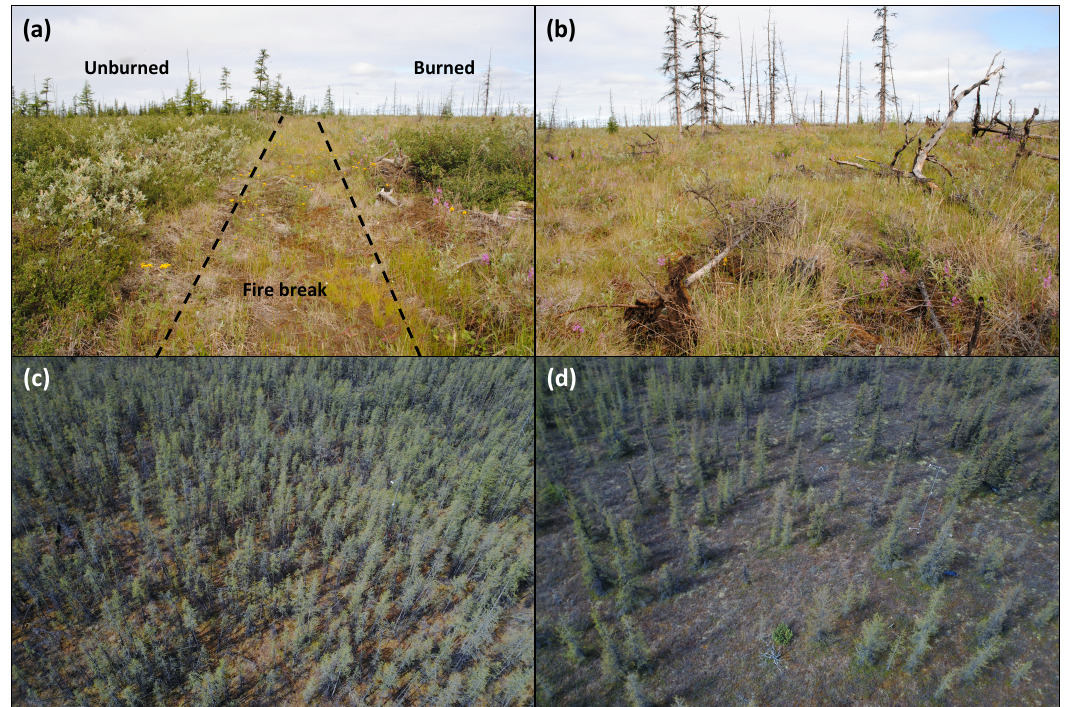
Figure 3. Impacts of fire on ecosystem structure in Siberian larch forests. A firebreak near the town of Cherskii (a) shows the contrast between burned and unburned areas ∼ 10 years post-fire, where apparent larch and shrub recruitment failure has resulted a transition to graminoid dominance ( b ; detail of burned area). Nearby in a ∼ 70 year old burn scar high-density (c) and low-density (d) forests illustrate the impacts of fire severity on canopy cover, and correspond to large differences in soil thermal regimes and active layers depths of ∼ 40cm in the high-density stand and ∼ 90cm in the low-density stand (Loranty and Alexander, 2014). Photos Michael M.